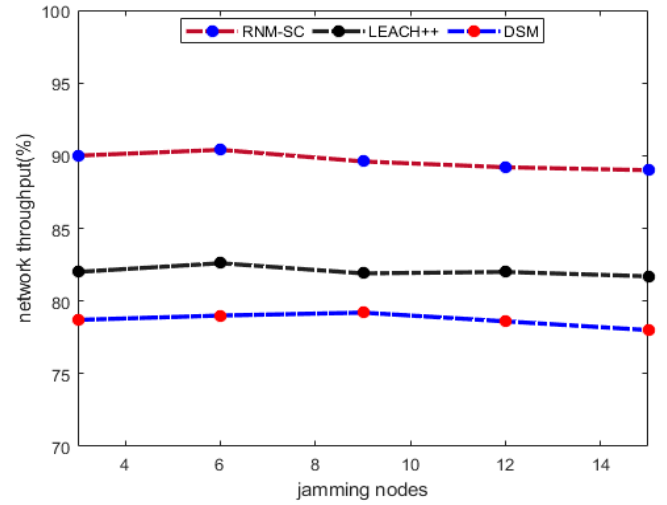
Figure 3. Network throughput and jamming